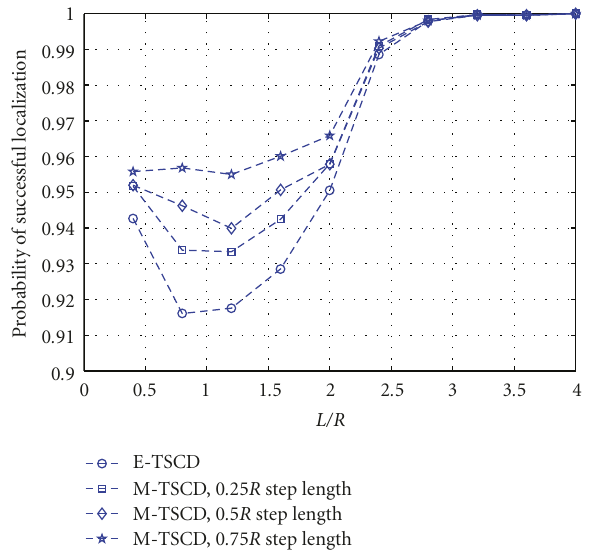
Figure 9: Time consumption of existing schemes and our schemes (the step length is 0 . 25 R for the mobility-aided TSCD scheme).